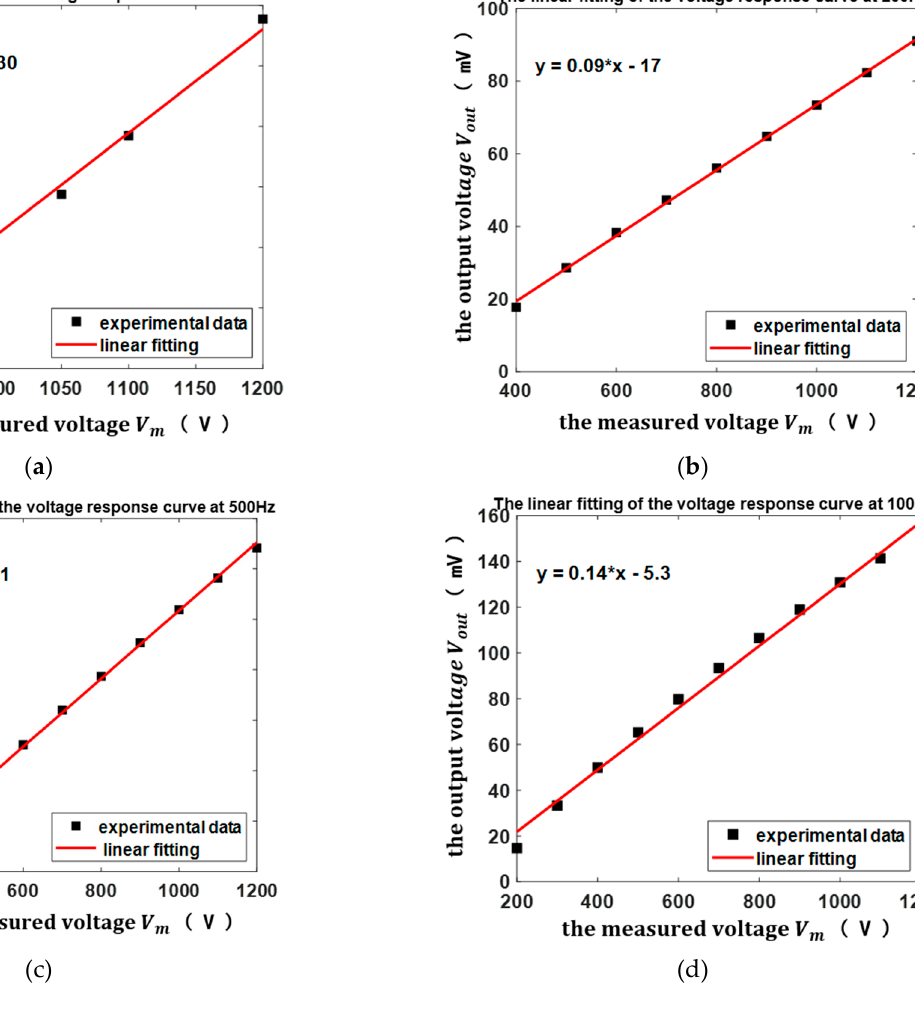
Table 2. The linearity, sensitivity, and resolution of the sensor.